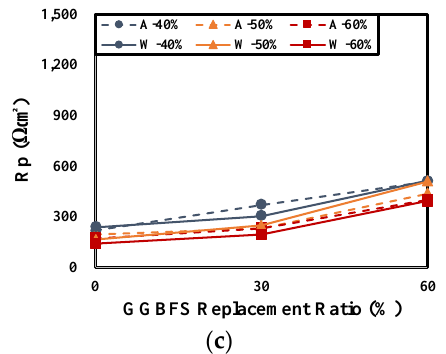
Figure 10. Impedance of rebars embedded in concrete according to the curing condition and GGBFS replacement ratio. ( a ) | Z | (Z total ), ( b ) R s (Z min ) ( c ) R p (Z max − Z min ).